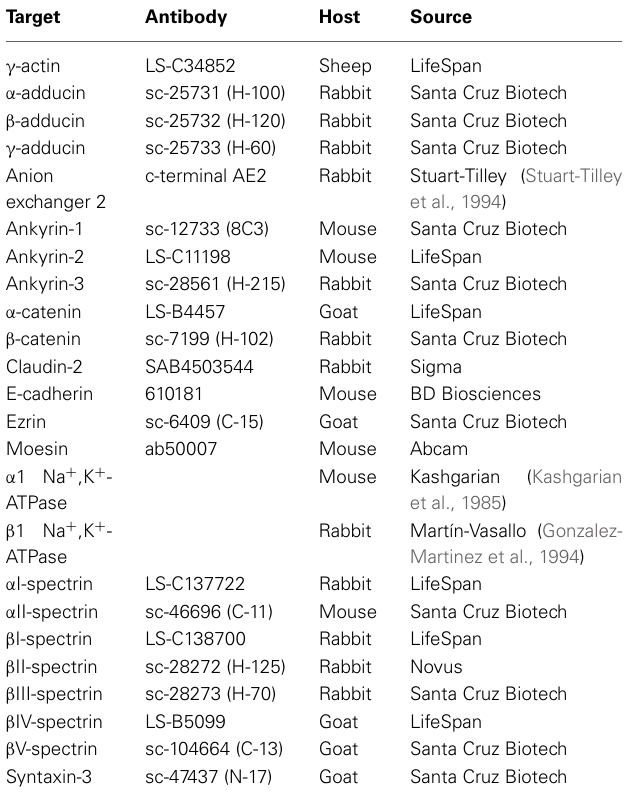
Table 1 | Primary antibodies applied in the